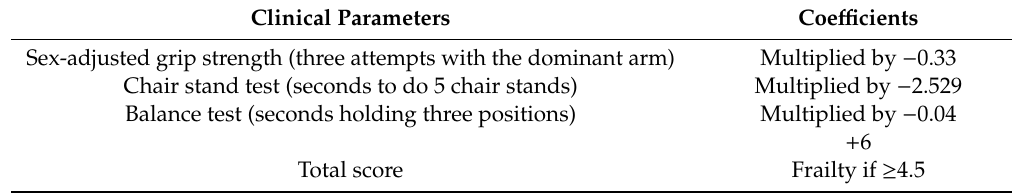
Table A5. Liver frailty index